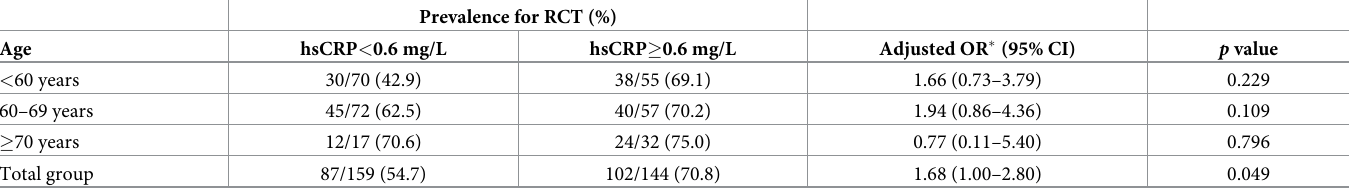
Table 3. Association between high-sensitive C-reactive protein and rotator cuff tear in relation to